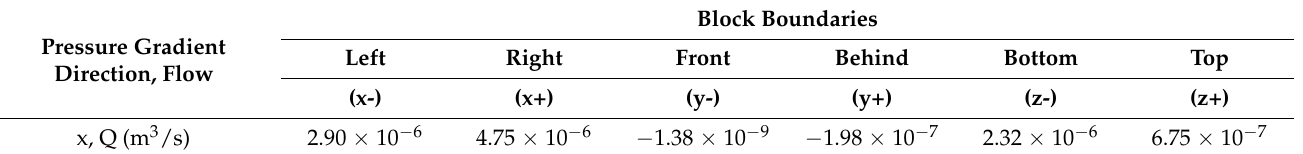
Table 1. Flow through DFN block boundaries with pressure gradient in the x